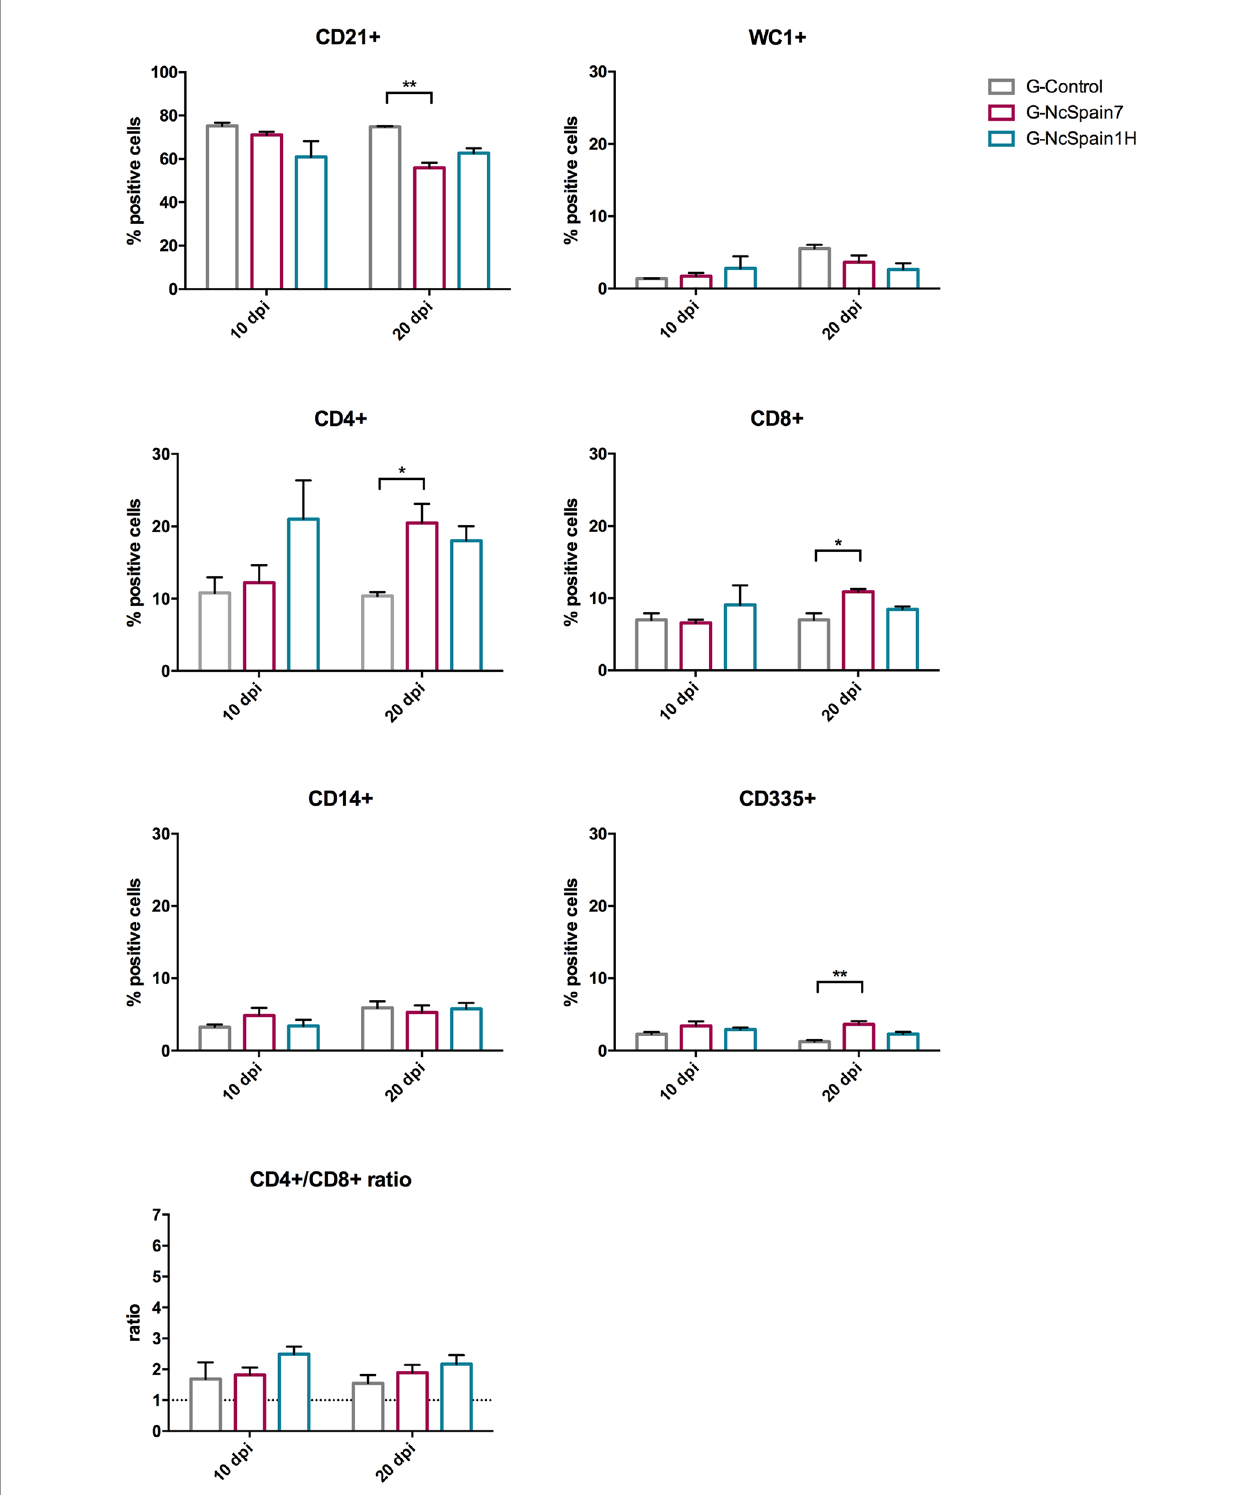
FIGURE 3 | Relative percentage of immune cells in iliofemoral lymph nodes from Nc-Spain7- and Nc-Spain1H-infected heifers. Graphs indicate the relative percentage of cells positive for CD21, WC1, CD4, CD8, CD14 and CD335 surface markers, and CD4+/CD8+ ratio surface markers in the population of immune cells obtained from the iliofemoral lymph node of uninfected heifers (G-Control) and heifers challenged with Nc-Spain7 (G-NcSpain7) and Nc-Spain1H (G-NcSpain1H) tachyzoites culled at 10 or 20 dpi. The results are represented as the mean+SD. Asterisks indicate signi fi cant differences. ** P <0.01, * P <0.05.